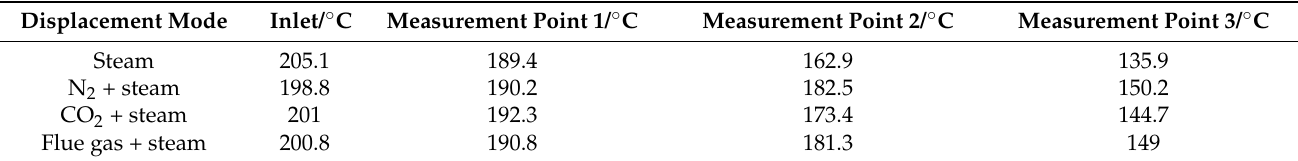
Figure 9. The comparative curves of the stable temperature of the measurement points under different displacement modes. Table 4. The stable temperature of the measurement points under different displacement modes.